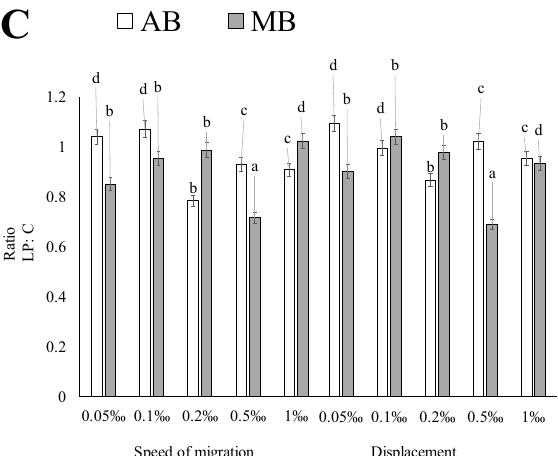
Figure 1. Effects of the digest on the speed and migration of human gastric cancer (AGS) cells. ( A )Adzuki bean (AB), ( B )mung bean (MB), and ( C ) comparison control vs. probiotic-rich sprouts. Bar graphs depict averaged AGS motility and displacements estimated from the trajectories of at least 50 cells (control = 100%). Means (±SD) for the selected activity followed by different letters are significantly different ( n = 9; p ≤ 0.05). C—control sprouts and LP—sprouts enriched with Lactobacillus plantarum.